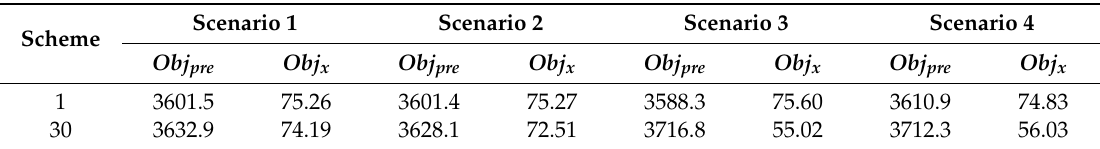
Table 5. The detailed Pareto optimal schemes obtained of EMOBCGSA by different scenarios under load